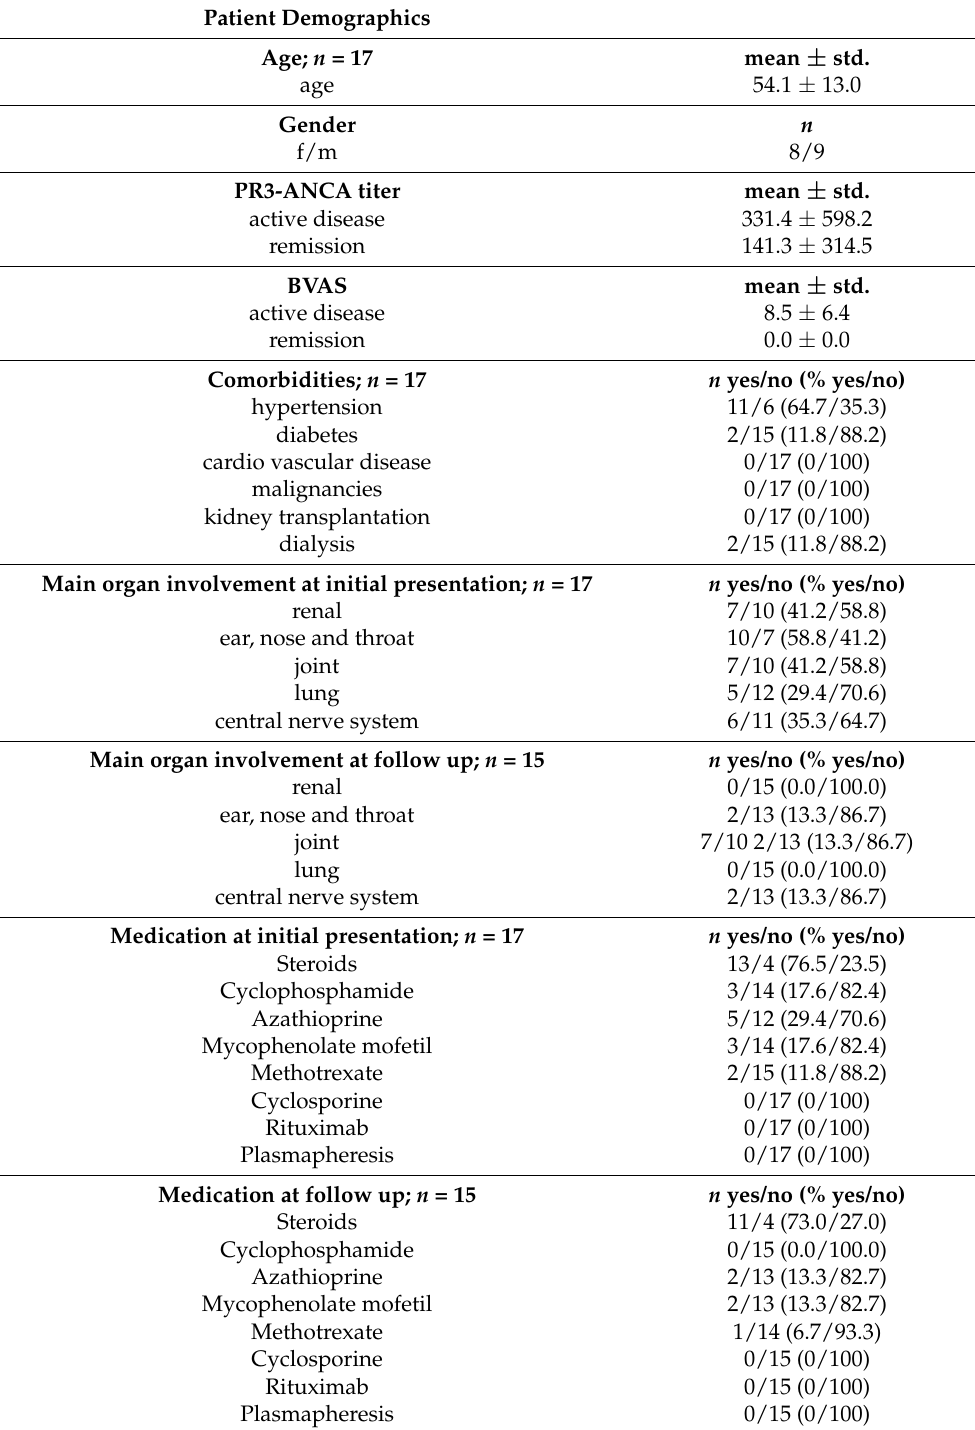
Table 1. Patients’